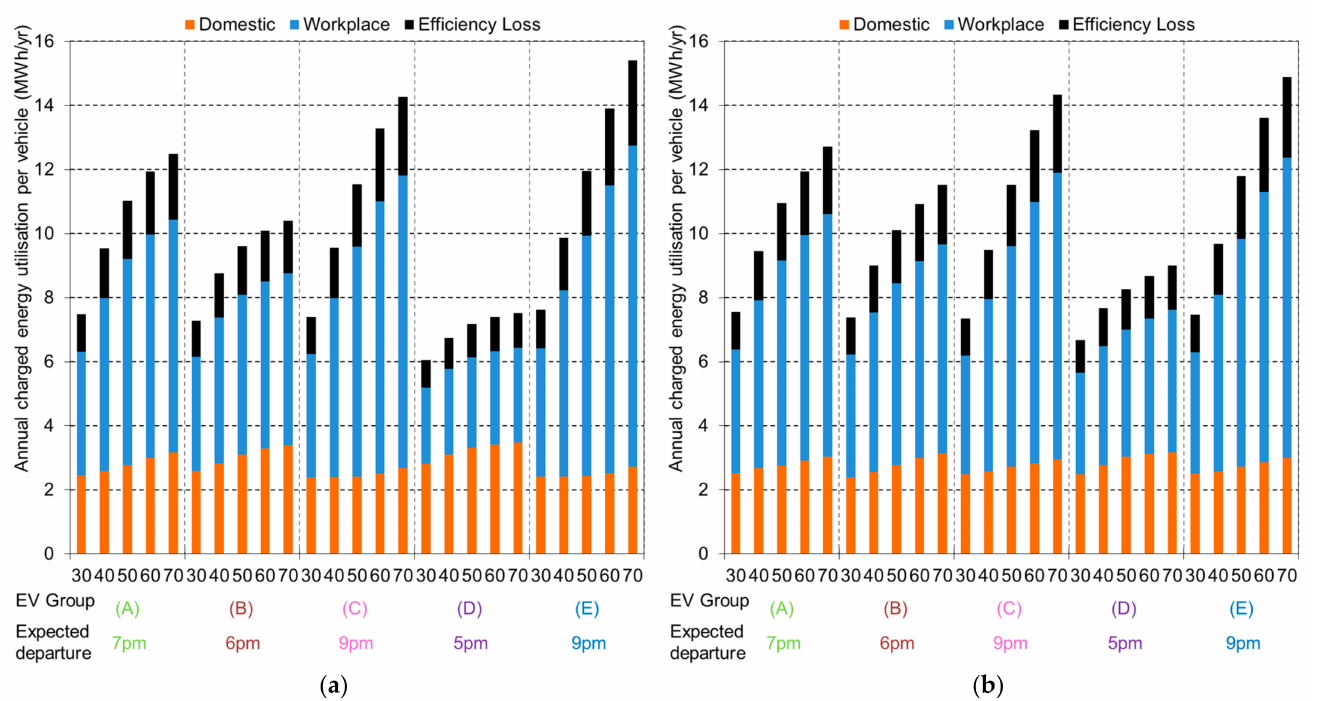
Figure 14. Average Annual Energy Utilisation per EV of each Battery Capacity of each EV Group: ( a ) Case B (EV Variety w/o Priority; ( b ) Case C (EV Variety with